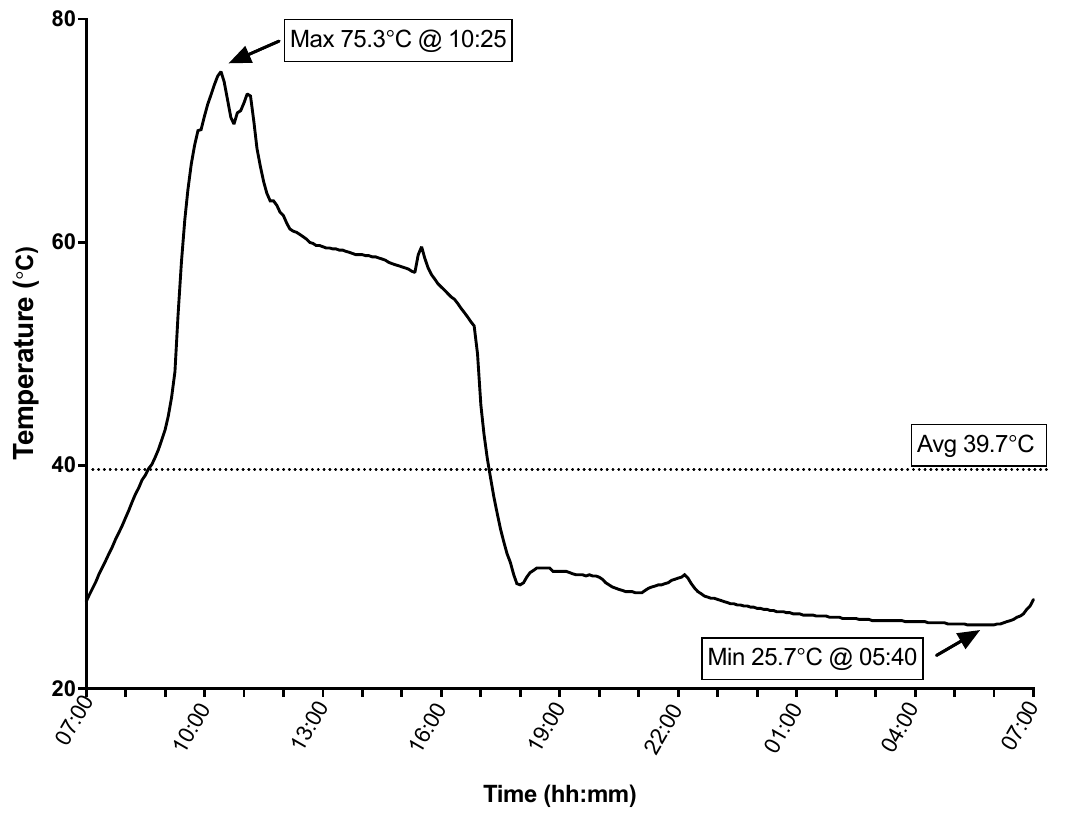
Figure 1. Temperature profile inside vehicle